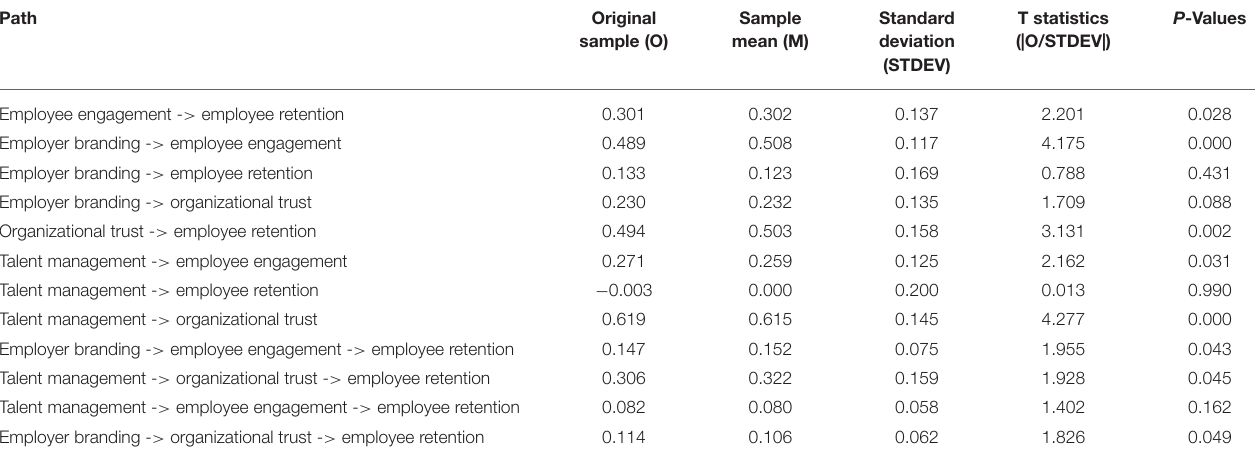
TABLE 1 | Path analysis. Path Original